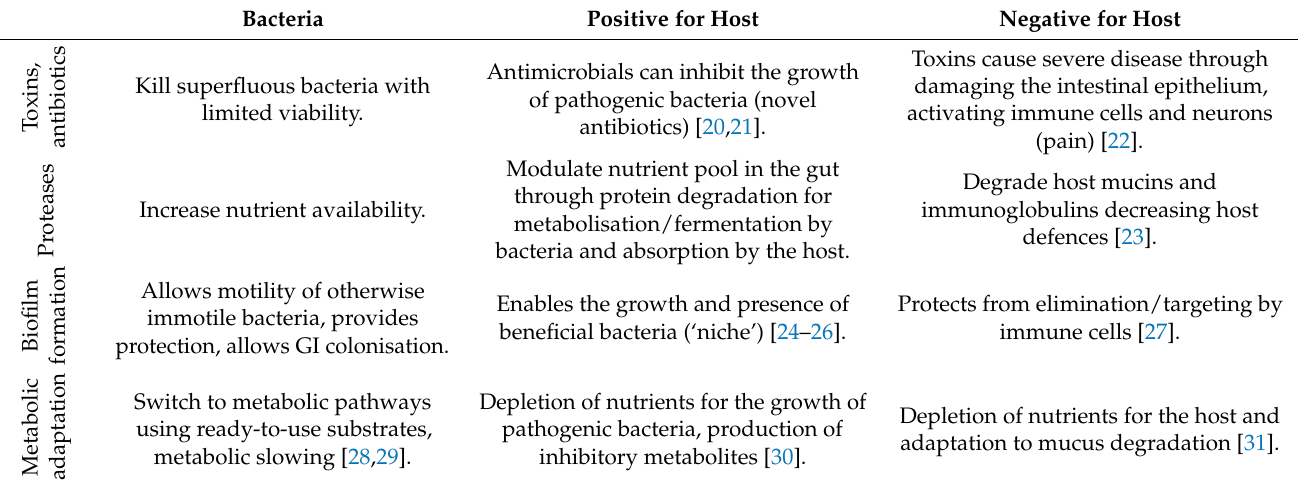
Table 1. QS activates target genes that benefit bacteria and have dichotomous effects on host physiology. Bacteria Positive for Host Negative for